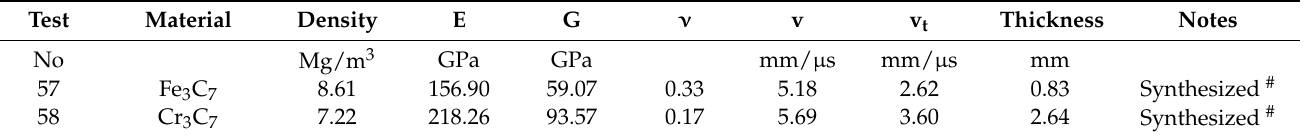
Table A4. Elastic constants of various minerals with longitudinal and transverse wave